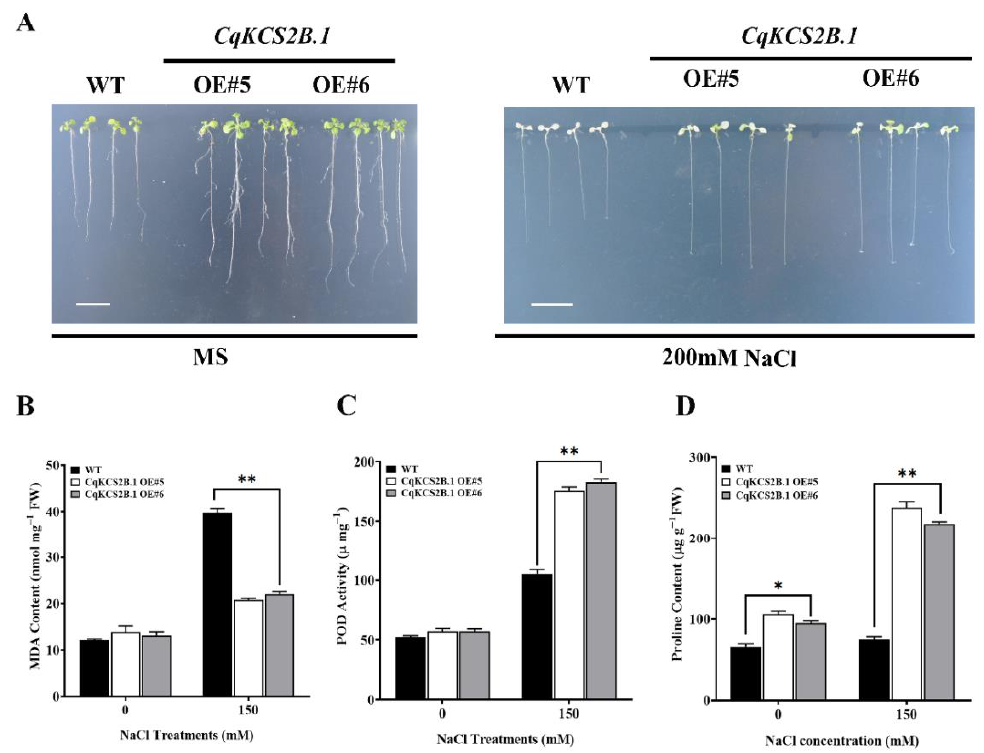
Figure 8. Phenotypic analyses of CqKCS2B.1 OE transgenic Arabidopsis seedlings under salt stress. ( A ) 1-week-old seedlings of WT, OE#5, and OE#6 were treated with 200 mM NaCl until the WT seedlings were completely dehydrated and then the plants were photographed. Two-week-old plants were treated with 150 mM NaCl for 24 h before determining ( B ) MDA content, ( C ) POD activity, and ( D ) proline content. Values are mean ± SD of 20 independent measurements. Statistically significant differences were detected by ANOVA. * and ** indicate significant differences between transgenic lines and WT at p < 0.05 and p < 0.01. Scale = 1 cm.